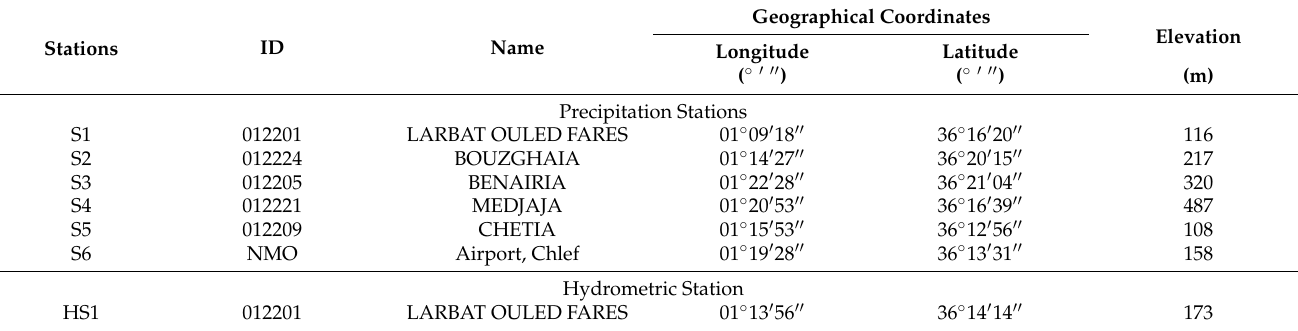
Table 1. Precipitation and hydrometric station